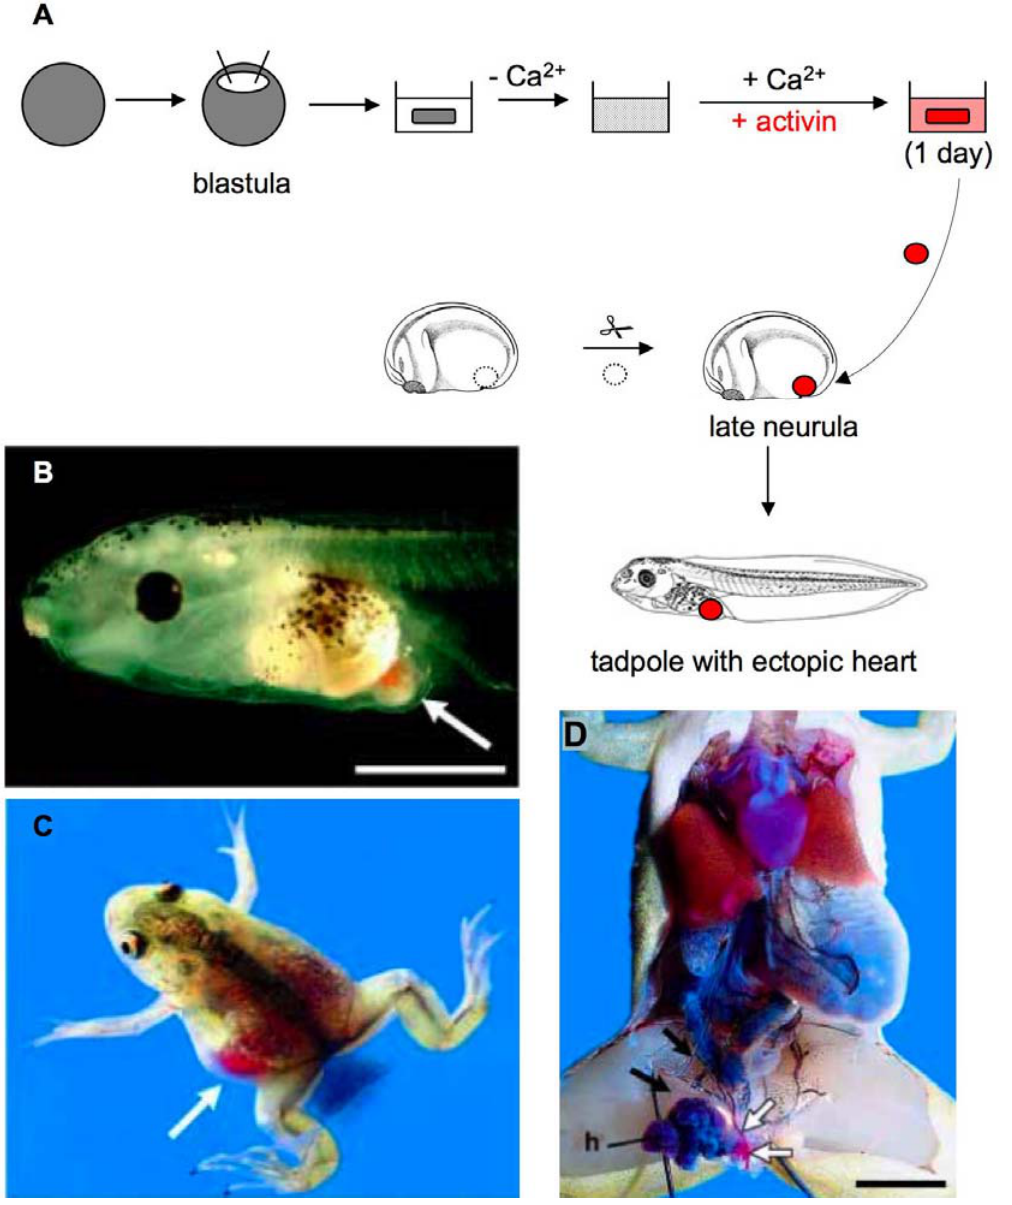
Figure 2. Generation of ectopic hearts by transplantation of in vitro induced ACC. ( A ) ACC were dissected at the blastula stage and dissociated by culturing in calcium-free medium. Dissociated cells were reaggregated by incubation in a saline solution containing calcium and activin. A fragment of the reassociated ACC was transplanted into the posterior abdomen of a neurula stage host embryo and developed to an ectopic beating heart at tadpole stage; ( B ) Tadpole embryo with a beating ectopic heart (white arrow); ( C ) Young frog displaying an ectopic in vitro induced heart. The ectopic heart is situated in the left abdomen and is filled with red blood cells (white arrow); ( D ) Internal anatomy of a one-year old frog with an ectopic heart (h) adjacent to the host's intestine. The blood flow from the host’s mesenteric artery (black arrow) to the anterior abdominal vein (white arrow) via the ectopic heart is indicated. (B–D) were reproduced from [37] with permission from The International Journal of Developmental Biology ( Int. J. Dev. Biol. 2003 , 47 , 405–410). Scale bars: (B) 1 mm, (D) 5